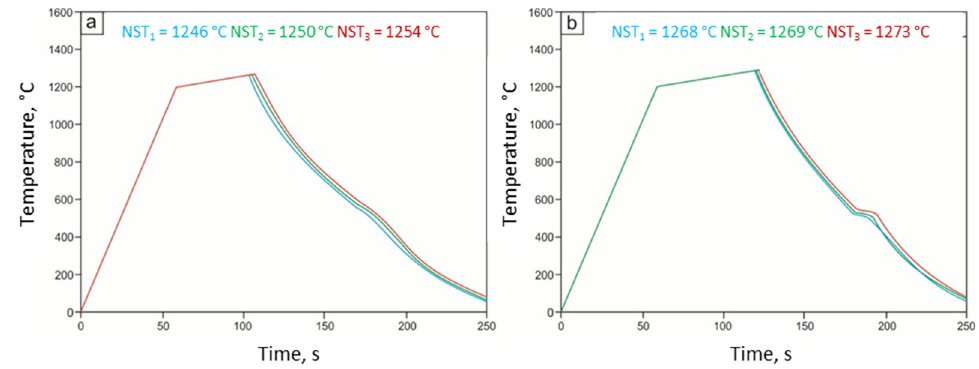
Figure 4. Diagrams of temperature changes as a function of time allowing for the determination of NST for steel: 27Mn-4Si-2Al-Nb ( a ) and 24Mn-3Si-1.5Al-Nb-Ti ( b ). The average value of the NST was determined from three measurements. The aver- age NST value for 27Mn-4Si-2Al-Nb steel is 1250 °C, while the average NST value for